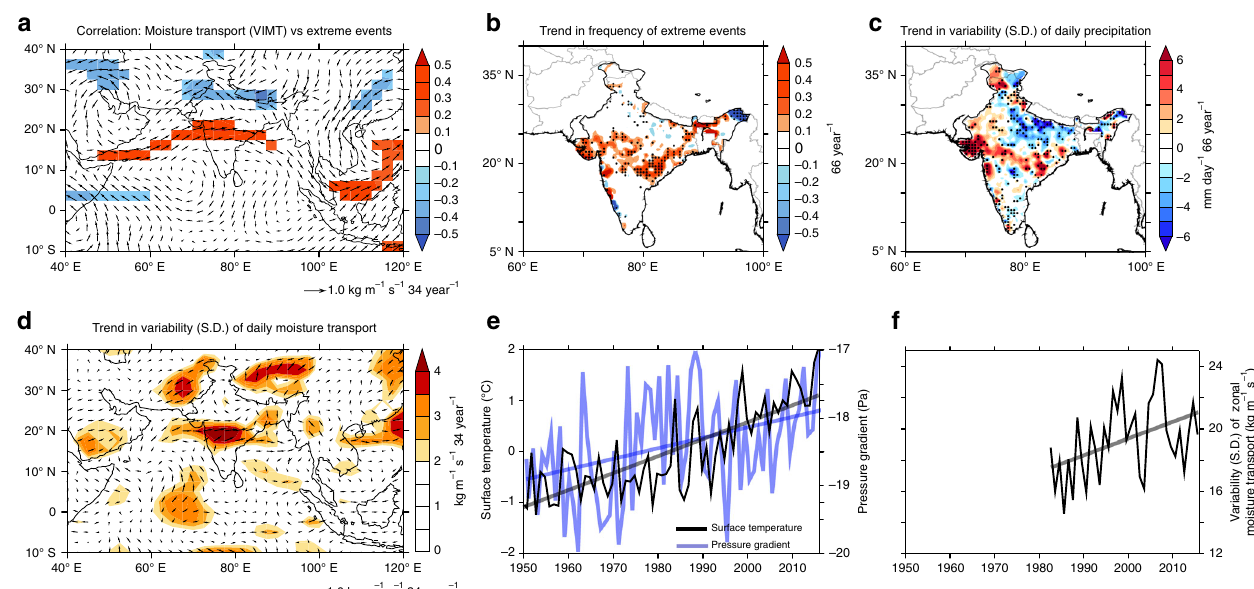
Fig. 3 Variability in moisture transport vs widespread extreme precipitation events. a Correlation between the number of extreme precipitation events over central Indian subcontinent (75° – 85° E, 19° – 26° N, inset boxes in Fig. 1) and vertically integrated (1000 – 200 hPa) moisture transport (vectors), for the years 1950 – 2015. The color shades indicate the correlation with the zonal component of the moisture transport at each grid point. b Trend in the frequency of extreme precipitation events (66 year − 1 ), for the years 1950 – 2015. Trend in the standard deviations (S.D.) of c daily precipitation (mm day − 1 66 year − 1 ) and d daily vertically integrated moisture transport (kg m − 1 s − 1 34 year − 1 , vectors) during 1982 – 2015. The color shades indicate the trend in the S.D. of zonal component of the moisture transport at each grid point (kg m − 1 s − 1 34 year − 1 ). e Time series of the surface temperatures averaged over north